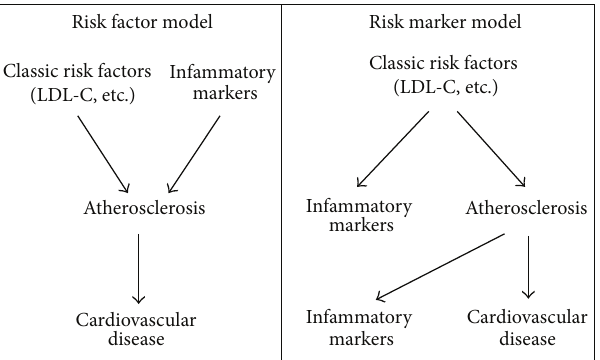
Figure 2: Models used to ascertain the role of an inflammatory